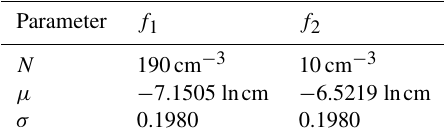
Table 4. Initial parameters for the distribution functions of P-DNN. Each distribution is characterized by a concentration parameter ( N ), expected value ( µ ) and standard deviation ( σ ). The initial param- eters are shown for the two lognormal distribution functions em- ployed in the formulation of